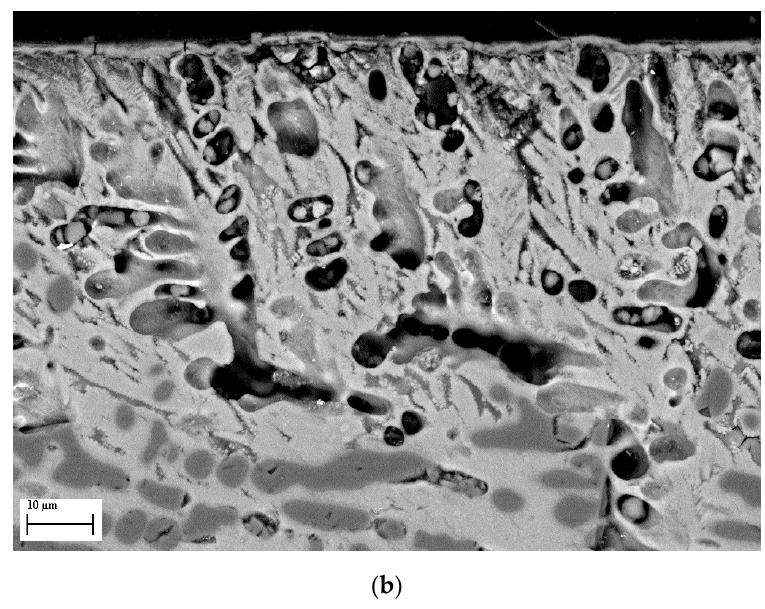
Figure 8. SEM image of a sample grown at 300 mm/h after soaking in the SBF solution for 28 days: longitudinal cross section ( a ) and a detailed zone of the sample surface in contact with the fluid ( b ).